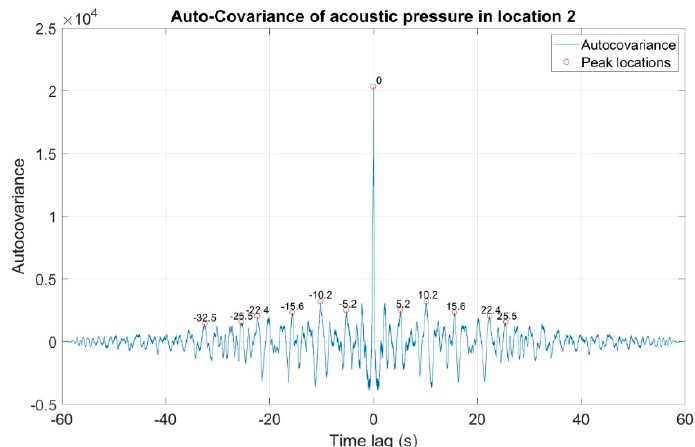
Figure 11. Course of auto-covariance function of infrasound signals generated by the investigated wind turbine, recorded in measuring setup number 2.